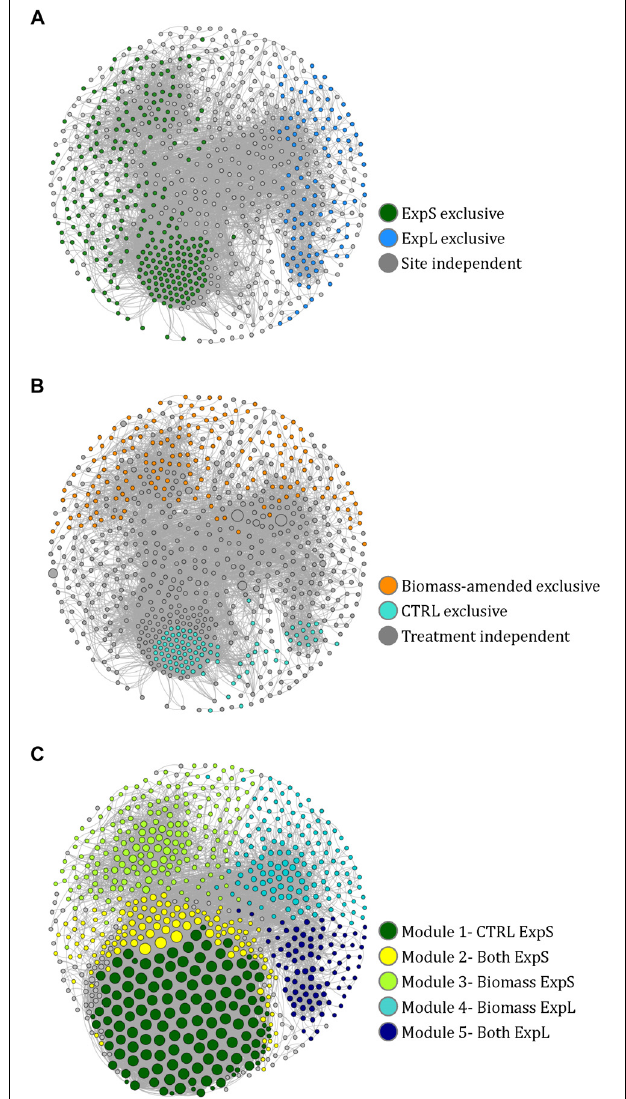
FIGURE 5 | Co-occurrence network of 757 nodes (i.e., significantly correlated OTUs) from the GDM biofilm communities. (A) Nodes colored according to their exclusive occurrence at one site. (B) Nodes colored according to their exclusive occurrence in particular treatments and sized according to read numbers. (C) Nodes colored according to modularity class and sized according to degree (i.e., number of links to other nodes). The naming of the modules in the legend is based on the observations in A and B